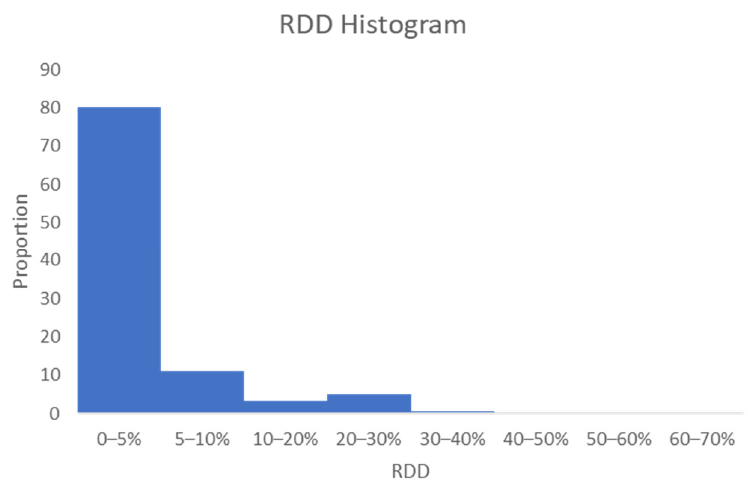
Figure 5. RDD Figure 5. RDD Histogram.